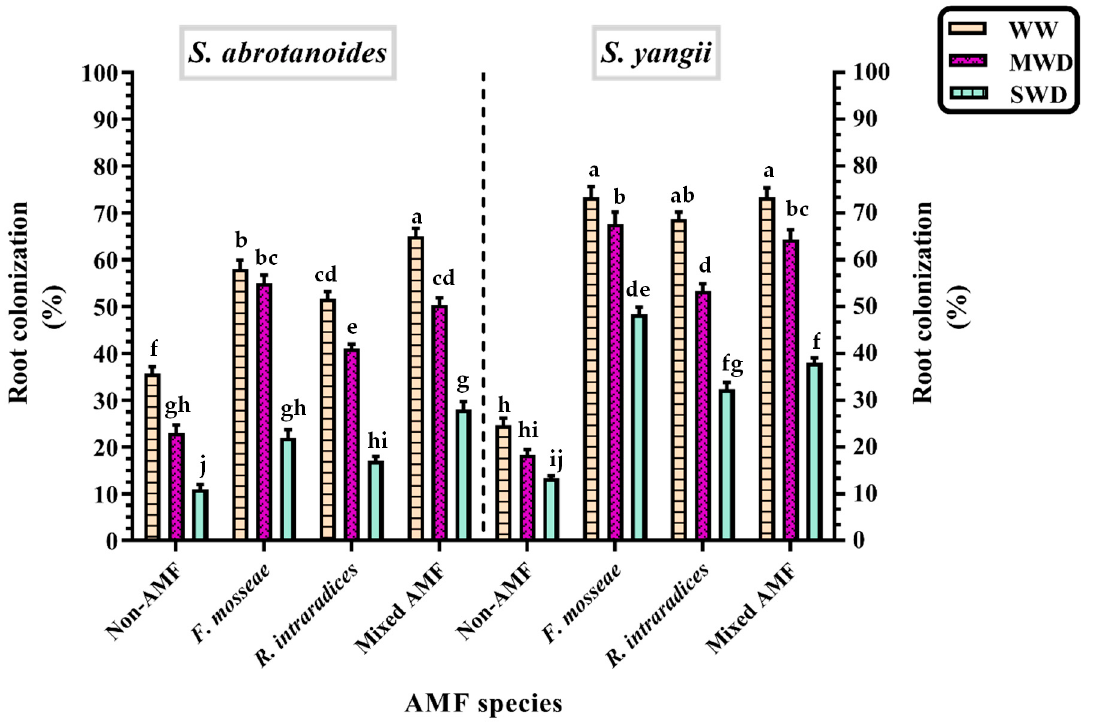
Figure 2. The root colonization (%) by AMF in S. abrotanoides and S. yangii under different irrigation regimes. Means ± SD with seven repetitions. Different small letters above the bars indicate a significant difference at p ≤ 0.05.